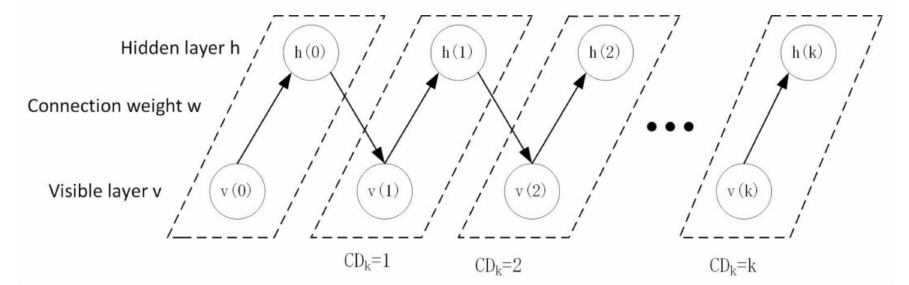
Figure 3. K-CD algorithm sampling